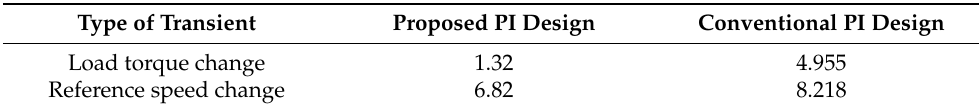
Table 4. Comparative IAE values for regulatory and tracking performances of the closed-loop SynRM